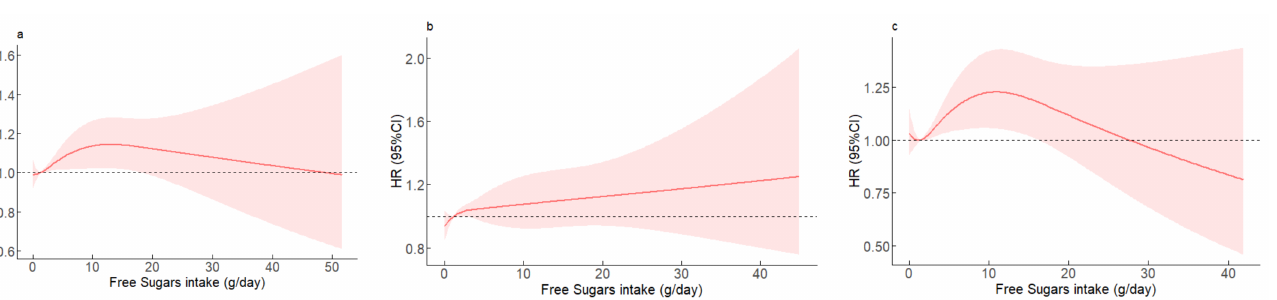
Figure 1. The relationships between free sugars intake and the risk of MetS during follow-up. The hazard ratio for MetS with the corresponding 95% confidence interval as a function of free sugars intake from Cox proportional hazard regression models adjusted for gender, age, educational level, place of residence, region of residence, individual annual income, drinking history, smoking history, physical activity, and total energy. ( a ) overall participants, p for nonlinear = 0.1623; ( b ) men, p for nonlinear = 0.4183; ( c ) women, p for nonlinear =